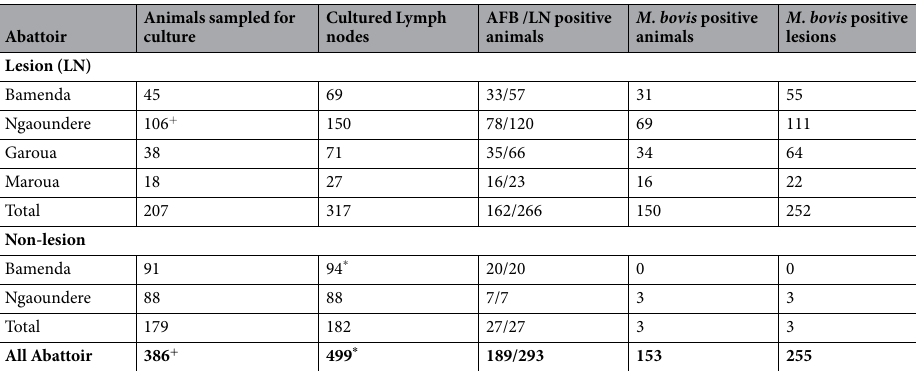
Table 1. Isolation of Mycobacterium tuberculosis complex from cattle lymph nodes sampled in four abattoirs in Cameroon between 2012–1013. * This figure includes three animals with lesions from which an extra non lesion lymph node was collected. + It should be noted that samples from six animals here were not cultured. LN & AFB stand for Lymph node and acid fast bodies